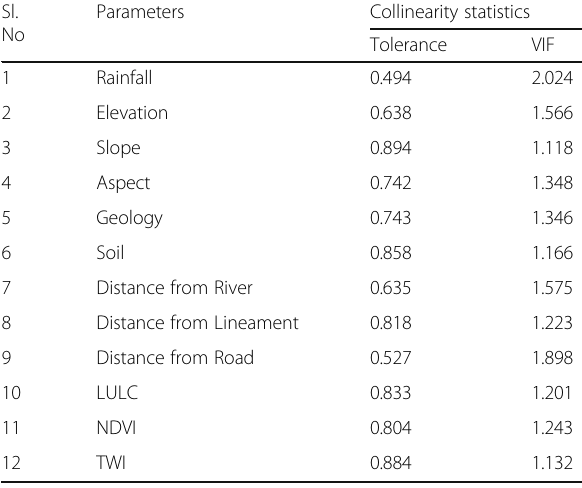
Table 1 Collinearity statistics of landslide determining factors Sl.